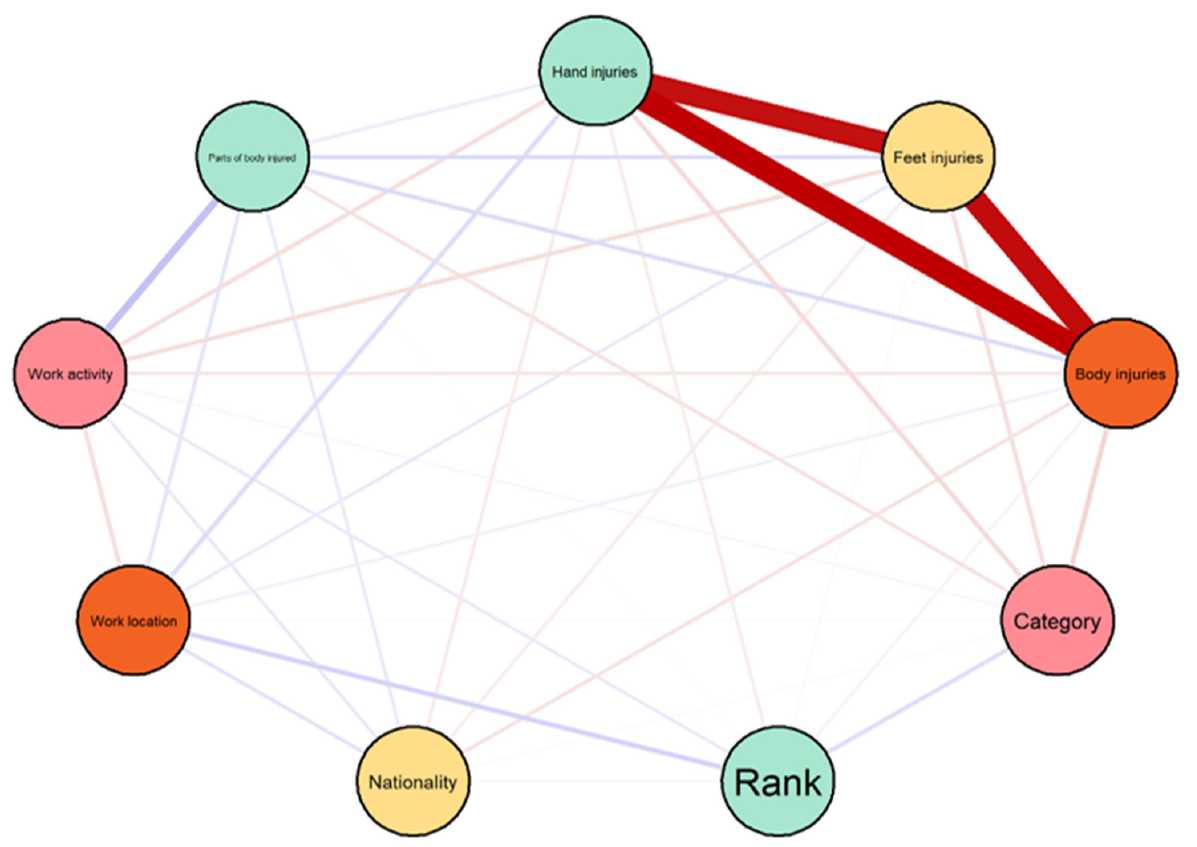
Figure 4. Gaussian graphical models (GGMs), partial correlations (pcor). Source: own process of data in RStudio.